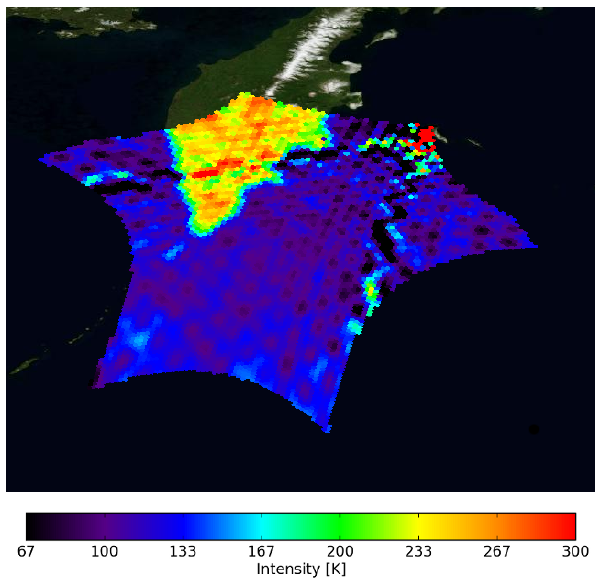
Fig. 2. A SMOS snapshot of Kamchatka and the Sea of Okhotsk as taken by MIRAS. The red area in the upper right of the snapshot represents high brightness temperatures due to RFI. In addition it produces ringing structures because of the inverse Fourier transform like reconstruction of the